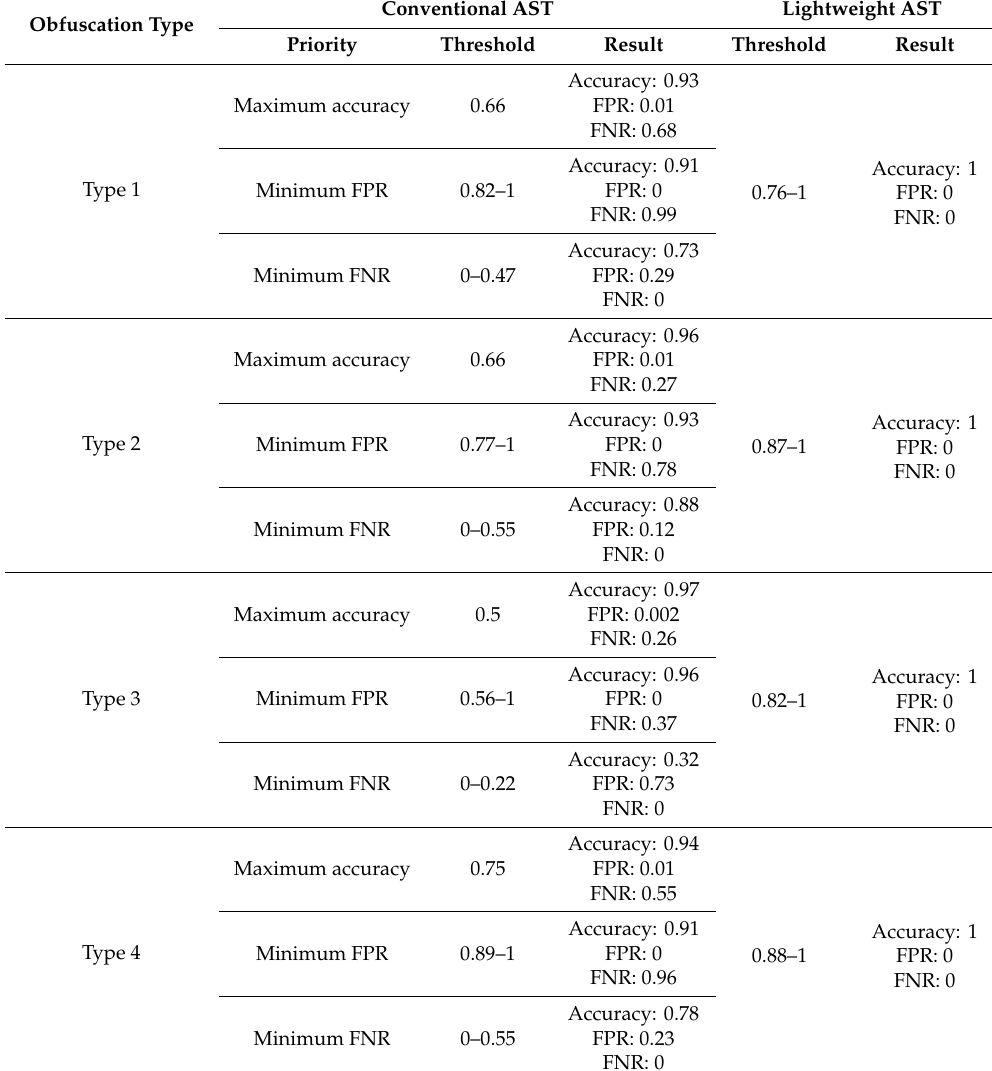
Table 6. Classification accuracy, FPR, and FNR according to the threshold in conventional and lightweight